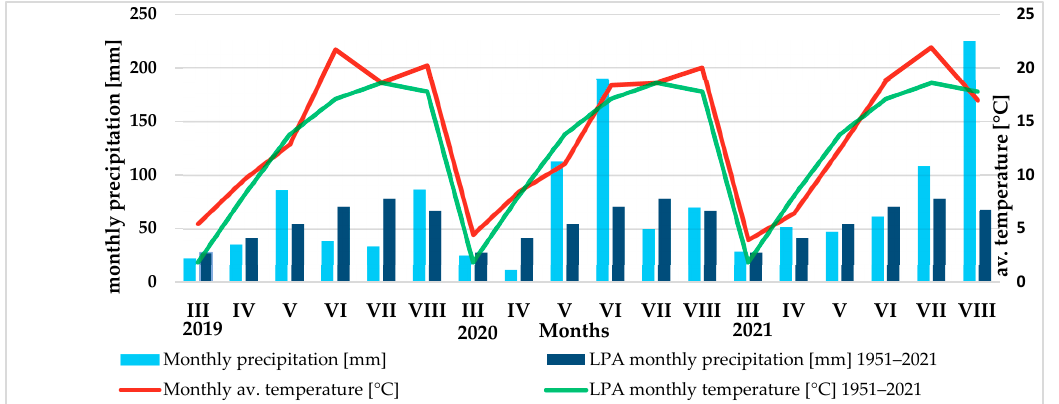
Figure 7. Total precipitation and mean monthly air temperatures for each growing season (2019–2021) compared to the long period average (1951–2021). Table 5. Values of the Selyaninov hydrothermal index (k) in each growing season (2019–2021).